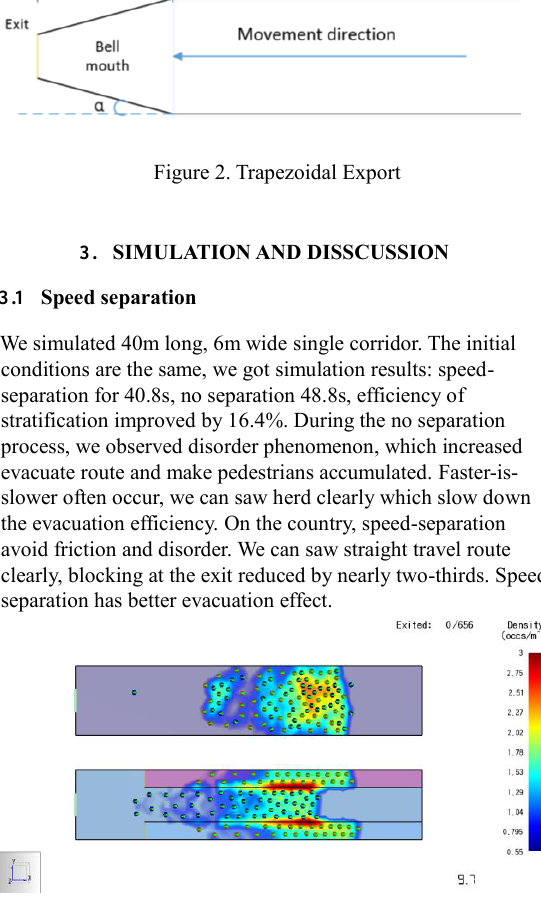
Figure 3. Comparison of stratification and